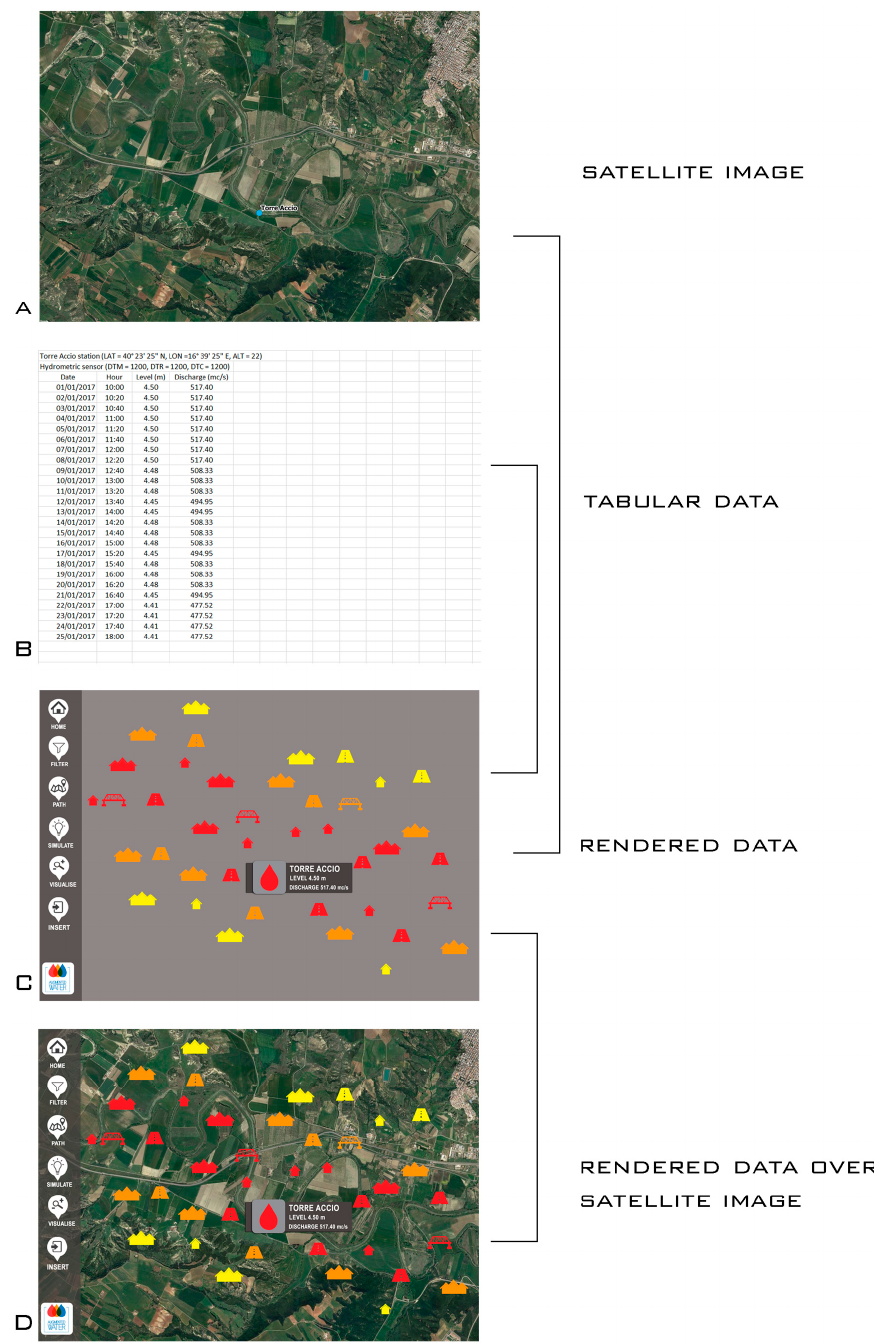
Figure 7. Visualisation of heterogenous data. ( A ) Satellite image of the sample area; ( B ) Simulated data in tabular form; ( C ) Models outputs are rendered in AR mode (different colours of billboards corresponding to different criticality levels); ( D ) Layers are blended together in multiple steps.